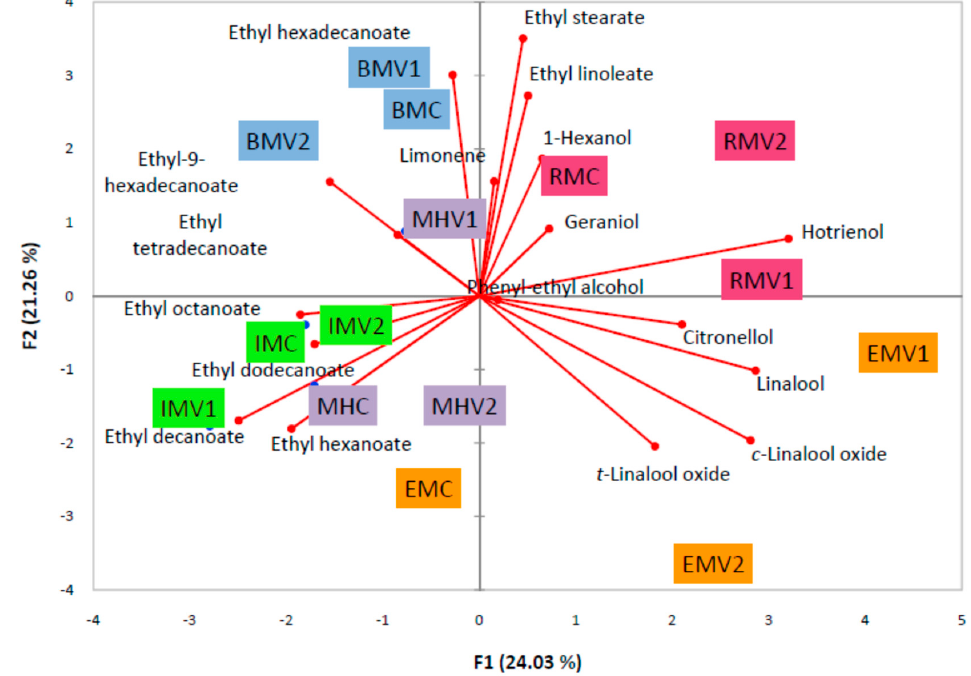
Figure 2. Principal component analysis biplot of the volatile aroma compounds identified in grape brandy samples of Muscat cultivars.